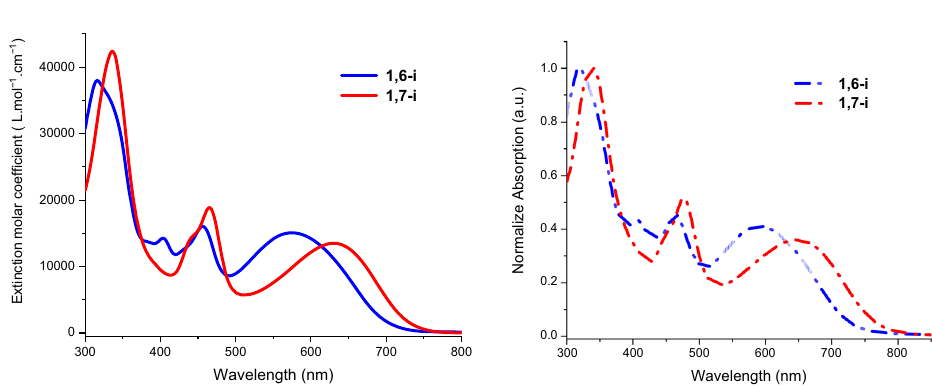
Figure 3. Molecular structures of 1,7-i (left) and 1,6-i (right) obtained by X-ray diffraction.